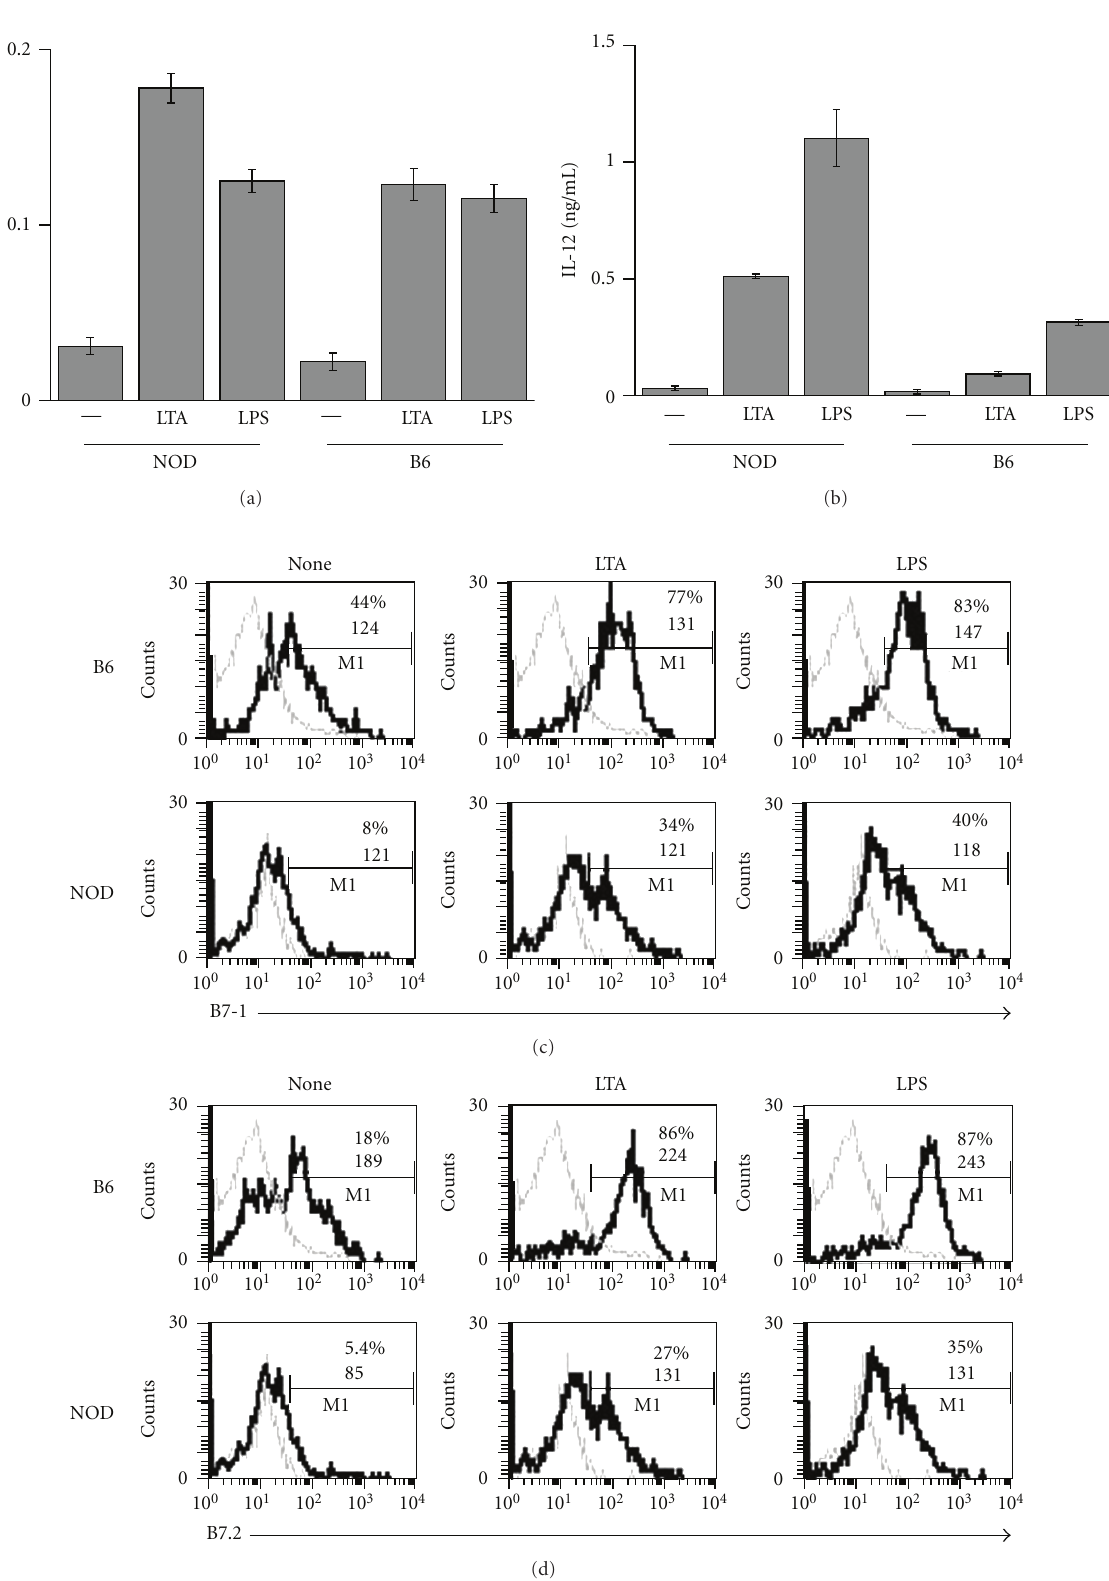
Figure 1: E ff ect of LTA on NOD and B6 DCs cytokine production and surface marker expression. BM-DCs from NOD mice were stimulated in vitro with 10 μ g/mL of LTA from S. aureus (LTA), 100ng/mL of LPS, or medium alone (—or none). After 24 hrs, supernatants were collected and measured by ELISA for the presence of IL-10 (a) or IL-12 (b), or cells were collected and labeled with anti-CD11c, anti-CD11b, and anti-B7-1 (c) or anti-B7-2 (d) antibodies, and analyzed by FACS after gating on CD11b + CD11c int